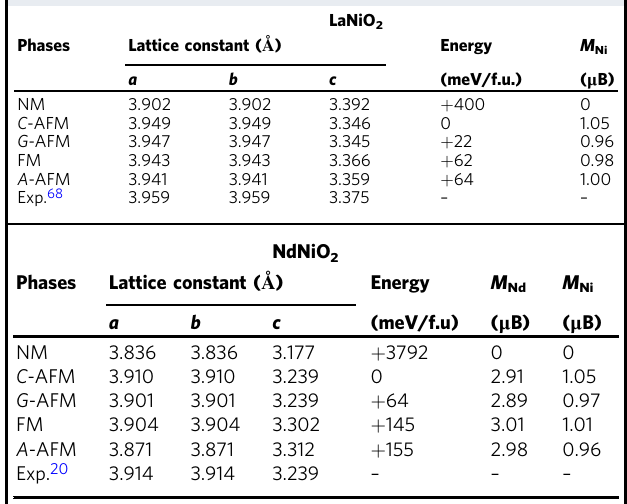
Fig. 1 Various crystal structures considered are shown. a Non-magnetic (NM), b ferromagnetic (FM). Three magnetic exchange couplings in the Ni sublattice are: J 1 (in-plane nearest-neighbor), J 2 (out-of-plane nearest-neighbor) and J 3 (out-of-plane next nearest-neighbor), c C -type antiferromagnetic ( C -AFM), d A -type antiferromagnetic ( A -AFM). e G -type antiferromagnetic ( G -AFM) phase. The light blue, green, and red balls represent La (Nd), Ni, and O atoms, respectively. The light blue and green arrows denote different magnetic moment directions. Note that there is no local magnetic moment on La. Table 1 Comparison of theoretically predicted properties of various magnetic phases of LaNiO 2 and NdNiO 2 .